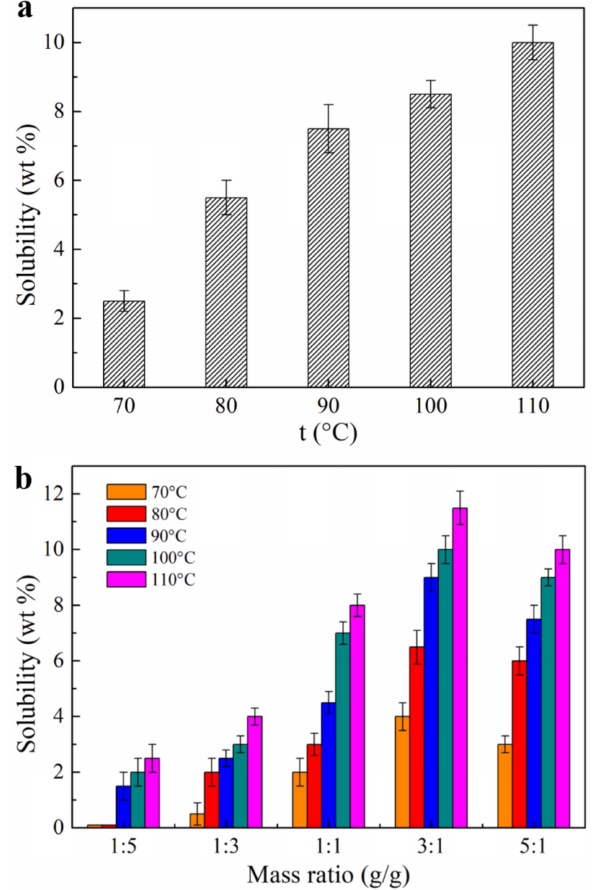
Figure 5. Solubilities (g per 100 g of IL) of bamboo dissolving pulp cellulose (Degree of Polymerization: DP = 650) in ( a ) the synthesized [AAeim][OAc] solvent; and ( b ) [AAeim][OAc]/DMSO (dimethyl sulfoxide)co-solvent system at different temperatures and mass